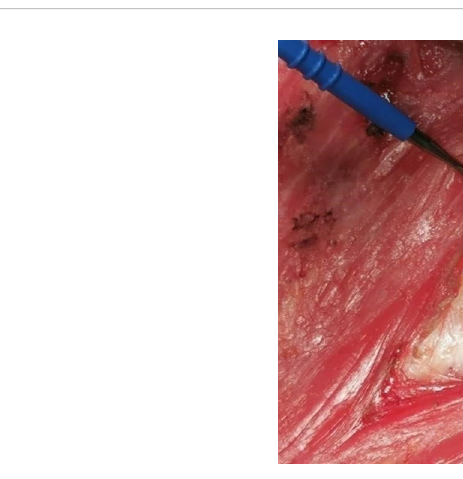
FIGURE 4 Intraoperative internal mammary sentinel lymph nodes (IM-SLN). The arrow shows the IM-SLN.